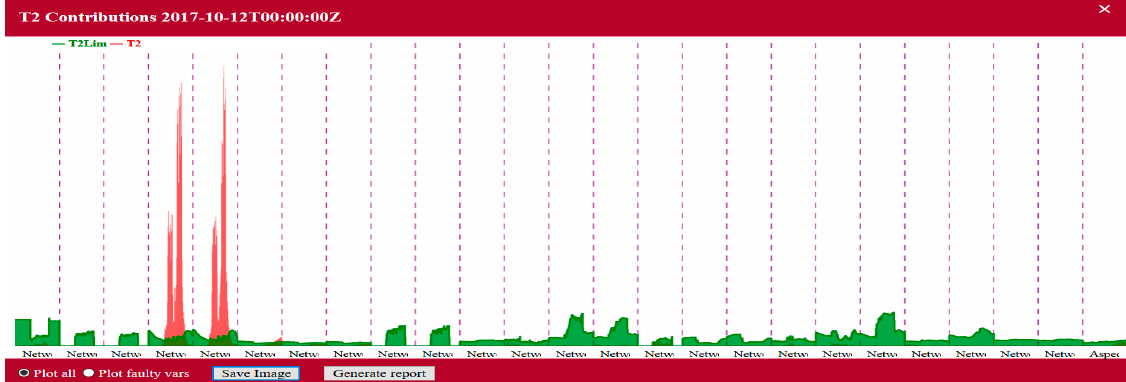
Figure 4. Example of contribution analysis of an unfolded observation with abnormal contribution to the variables.